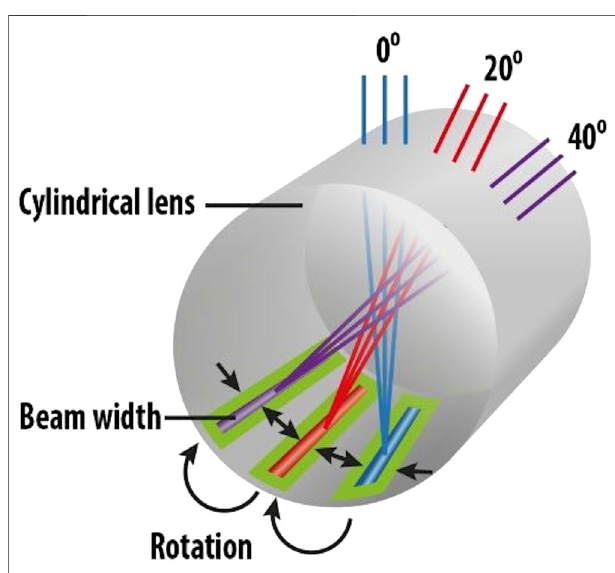
Frontiers in Energy Research |